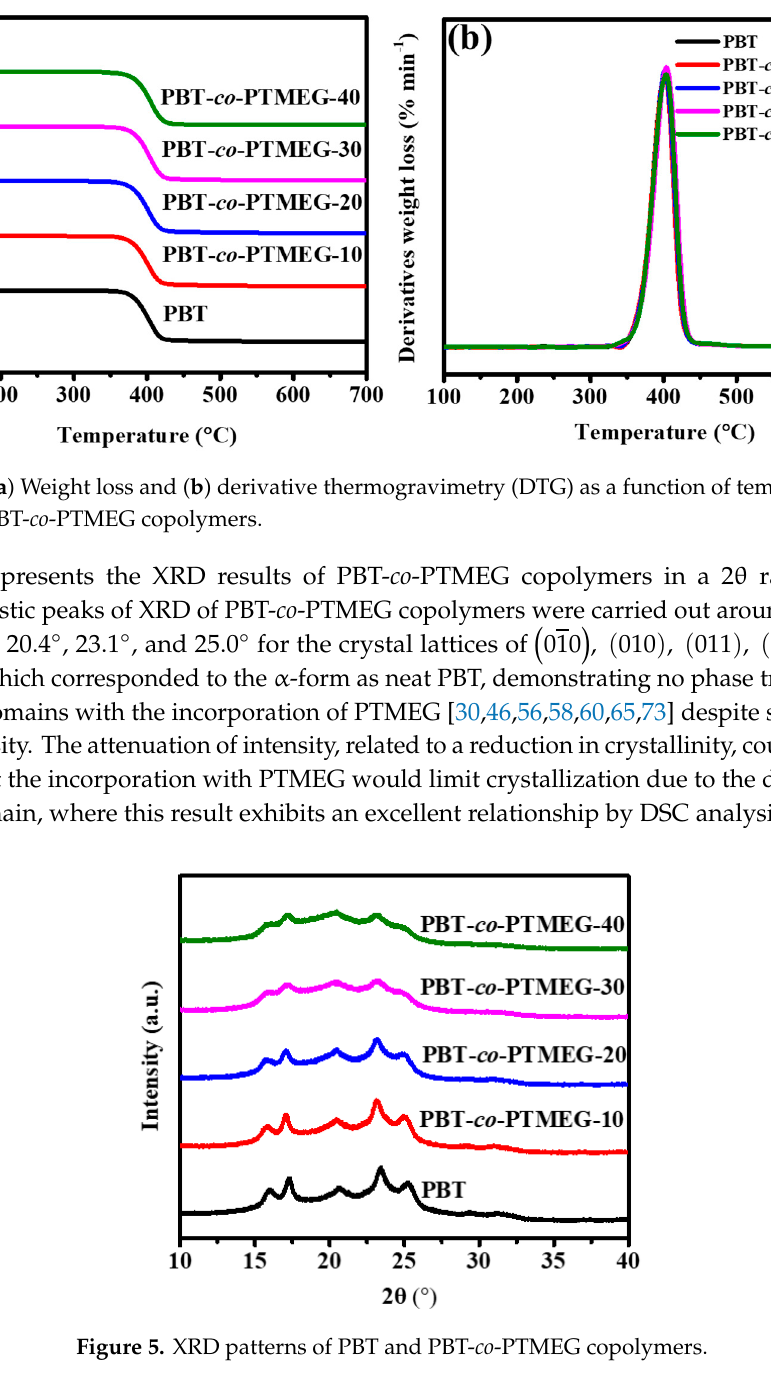
Figure 5. XRD patterns of PBT and PBT- co -PTMEG copolymers.